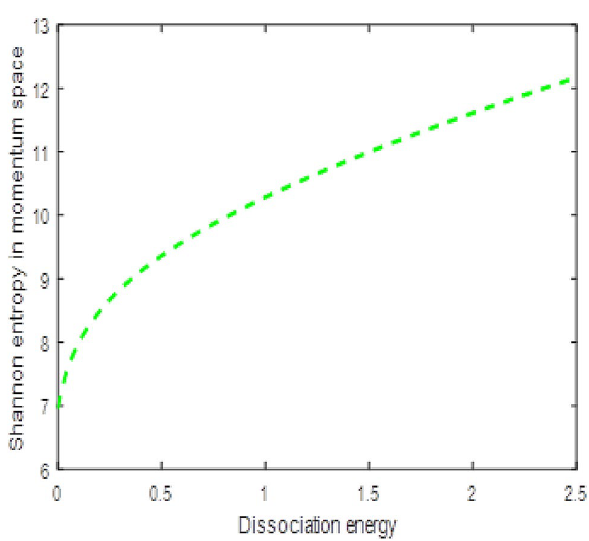
Figure 11. Shannon entropy for momentum space against the dissociation energy with µ = n = ℓ = (cid:31) = C = (cid:31) = 1 and r e = 0.2 of the multiple potential